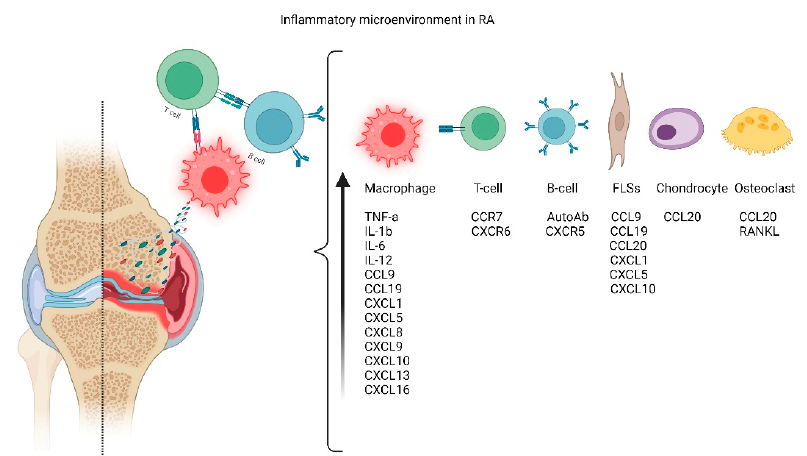
Figure 1. Inflammatory process. Regarding the etiology of RA, the cells responsible for articular dam- age include T-cells, B-Cells, Macrophages, and hyper-stimulated articular cells, such as synoviocytes (MLSs) and fibroblast-like synoviocytes